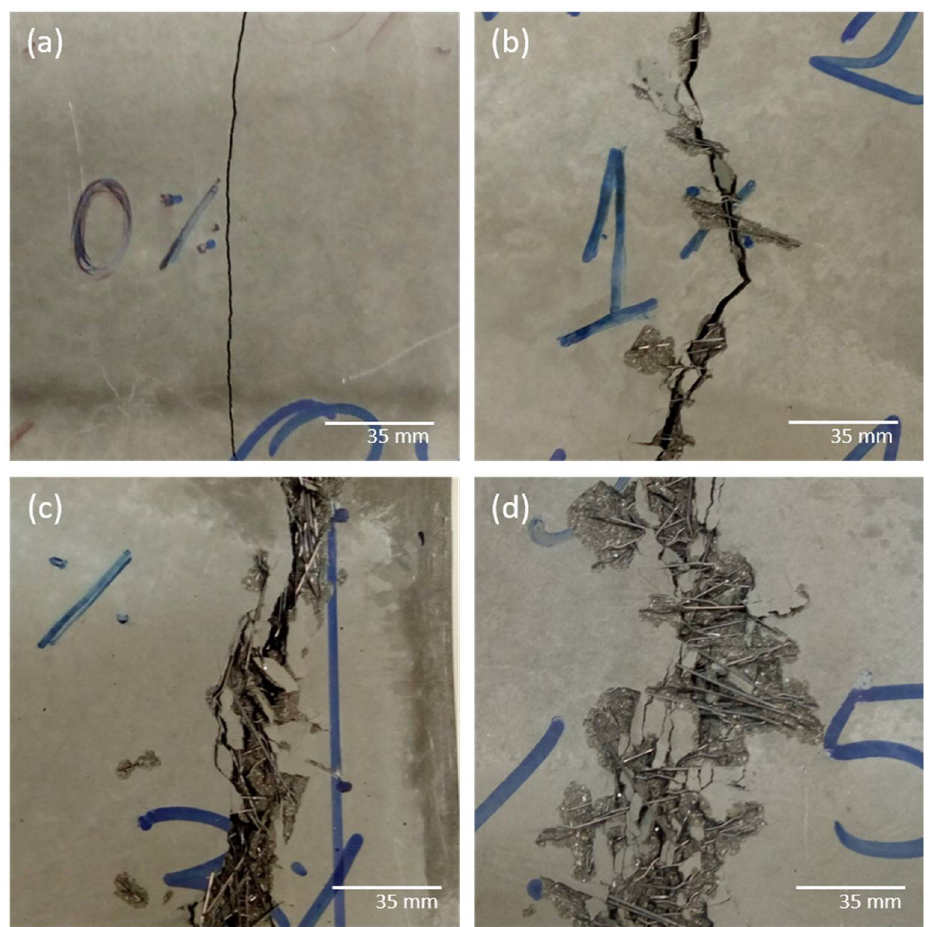
Figure 3. Crack profile of the slabs ( a ) without reinforcement, ( b ) 1% fibre, ( c ) 3% fibre and ( d ) 5% fibre.